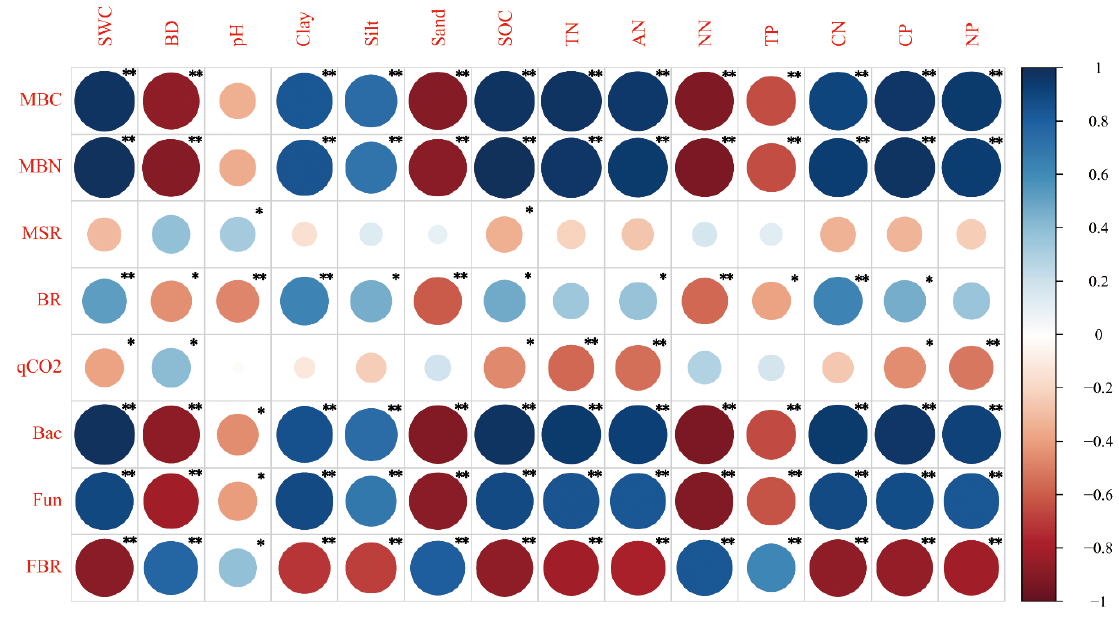
Figure 5. Correlation analysis between microbial properties and soil physical chemical properties in June. SWC, soil water content; BD, soil bulk density; Clay, soil clay content; Silt, soil silt content; Sand,